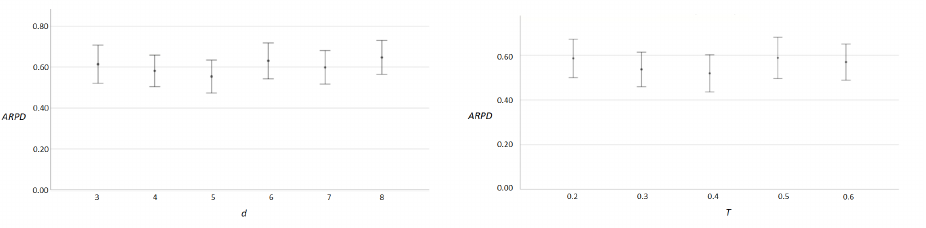
Figure 4. Calibration of d and T